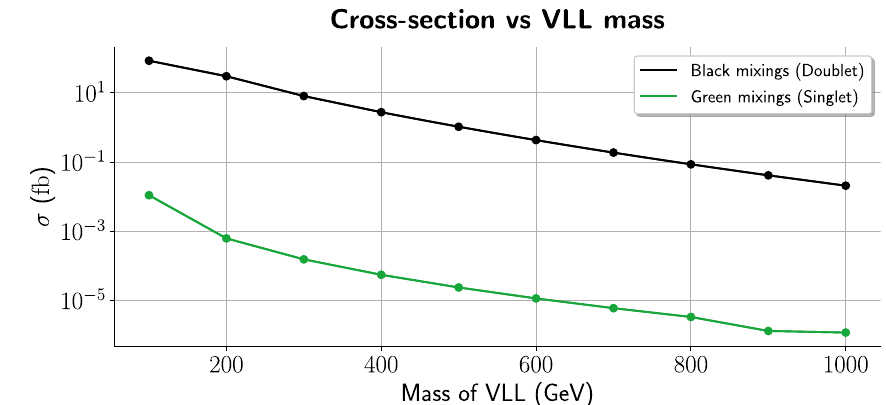
Fig. 6 Production cross section for both doublet and singlet topologies, in femtobarn (fb), as a function of the VLL’s mass, in GeV. The y -axis is shown in logarithmic scale. The black and green curves correspond to the same colour mixing scenarios in Eqs. (14) and